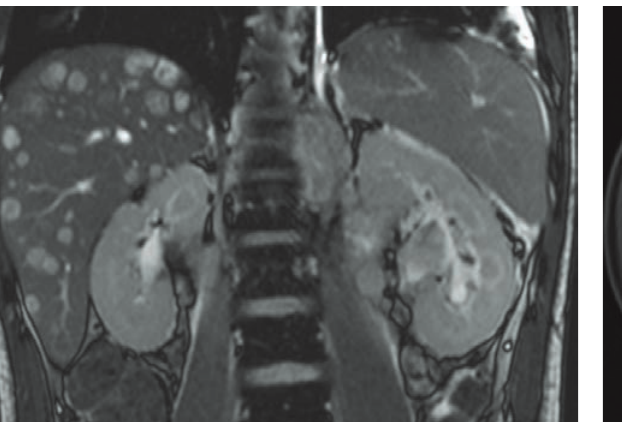
Fig. 10. Axial diffusion-weighted MR image at similar level as the above. Fig. 11. Axial ADC map MR image at a slightly inferior level.